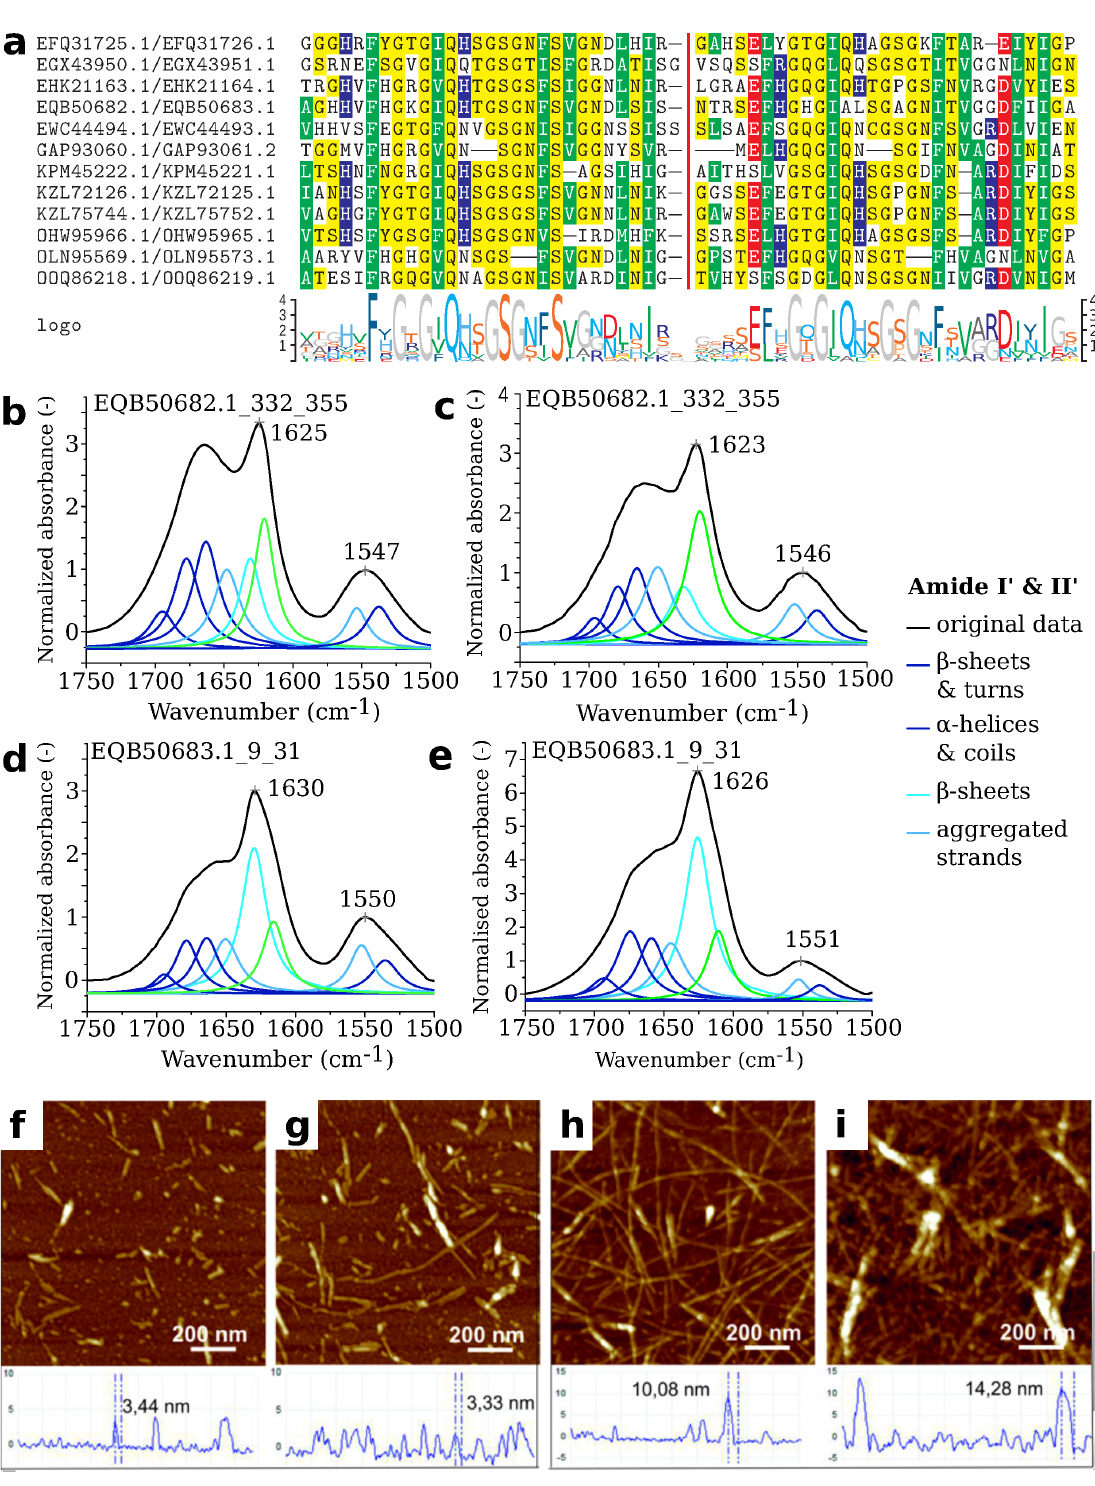
Fig 5. The PUASM motif. Alignment of the PUASM sequence pairs ( a )from effector C-terminus (left) and NLR N-terminus (right). Colors indicate residue hydrophobicity, curly brackets—the motif ranges. Deconvolution of ATR–FTIR spectra of air-dried peptide films of EQB50682.1_332_355 ( bc )and EQB50683.1_9_31 ( de )in the amide bands region (1750–1500 cm − 1 ). Spectra registered at 20˚C (68˚F) after dissolving ( bd )or after 40 days of incubation at 37˚C (98.6˚F) ( ce ).AFM images with cross-section profiles of peptides EQB50682.1_332_355 ( fh )and EQB50683.1_9_31 ( gi ).Samples imaged after dissolving ( fg )or after 40 days of incubation at 37˚C (98.6˚F) ( hi ).